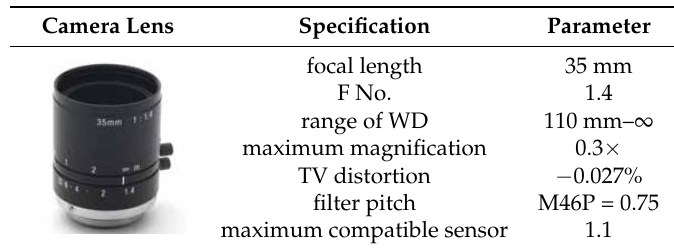
Table 3. The camera lens parameters.